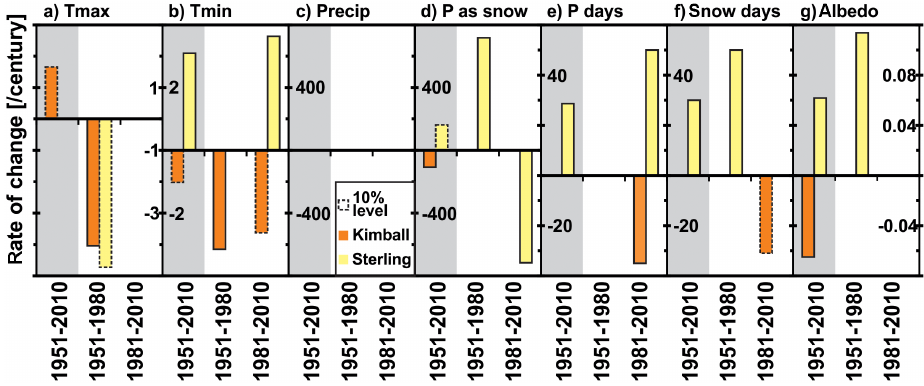
Figure 5. Significant rates of change for the seven variables (a–g) for the two focus stations over varying lengths of record (60